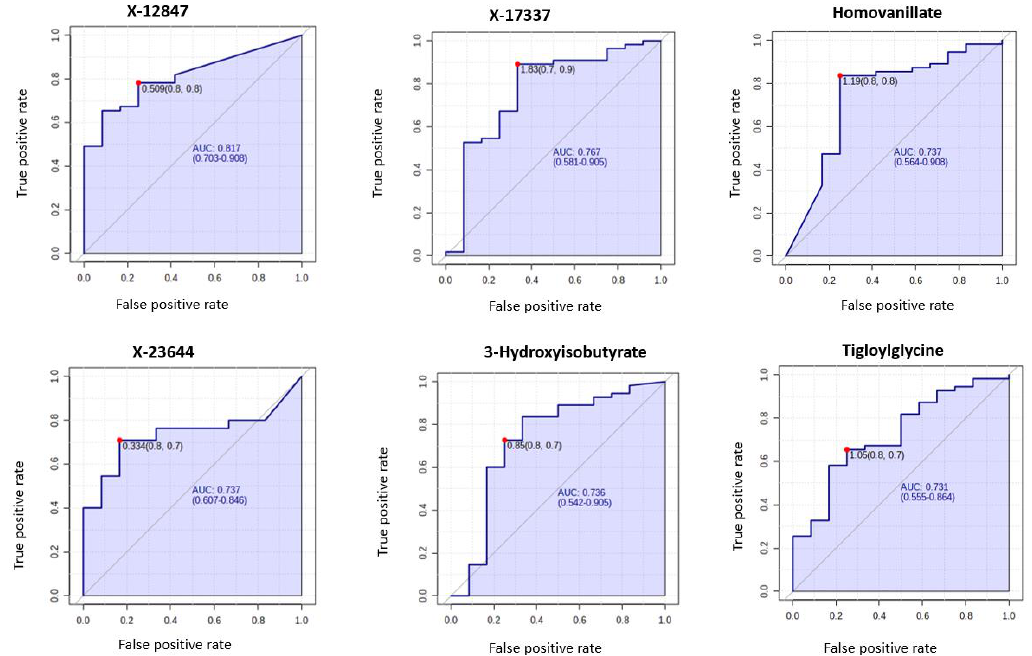
Figure 10. ROC curves of the promising biomarkers for the prediction of deep myometrial invasion ( n = 12) based on AUC analyses of n = 67 cancers. The optimal cut-off was based on the closest to the top left corner principle and is indicated by the red dot in the ROC curves. Metabolites starting with X are unnamed; the pathways of these are